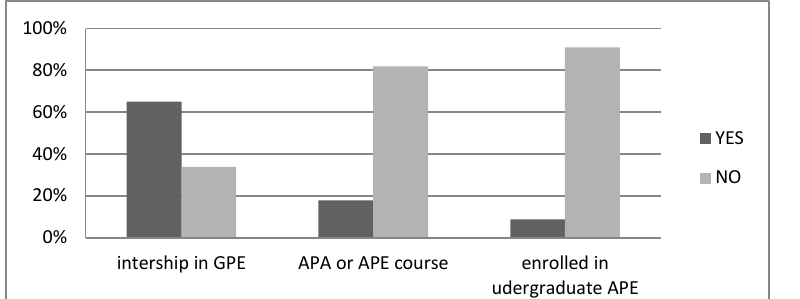
Figure 1 Percentage of PE students: a) who had internship in general physical education; b) who had experiences in adapted physical education or adapted physical activities course; c) who was enrolled in undergraduate or concentration in